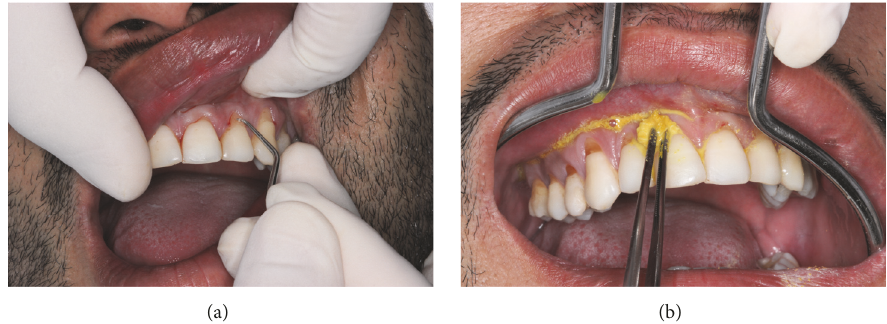
Figure 3: (a) Scraping and root smoothing. (b) Smear with tetracycline.